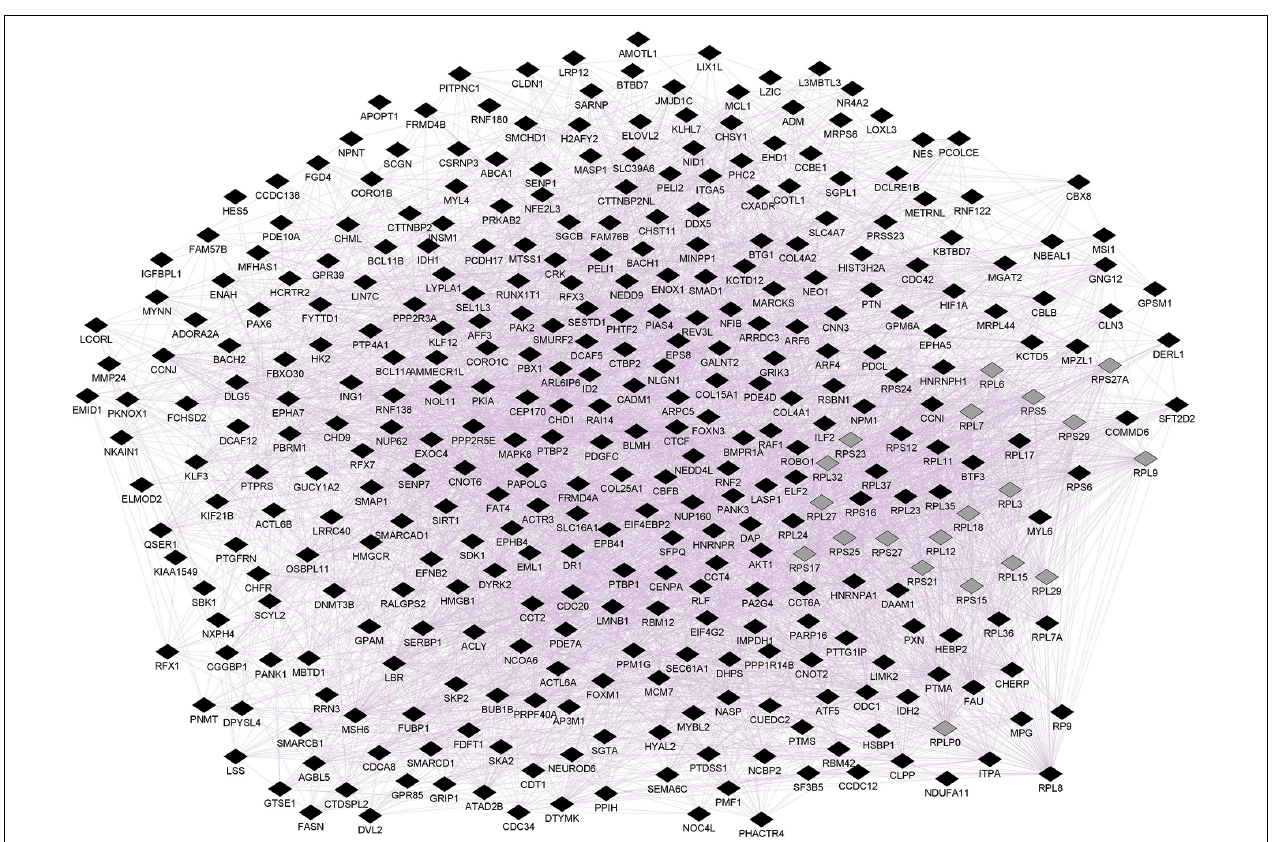
FIGURE 1 | Prefrontal CNR1 gene network using GeneMANIA. Black diamonds indicate query genes, whereas gray diamonds indicate related genes added by GeneMANIA. GeneMANIA converts mRNA expression data from Gene Expression Omnibus (GEO) to functional association networks, connecting co-expressed genes through purple lines. Node sizes represent gene scores, reflecting how often paths that start at a given gene node end up in one of the query